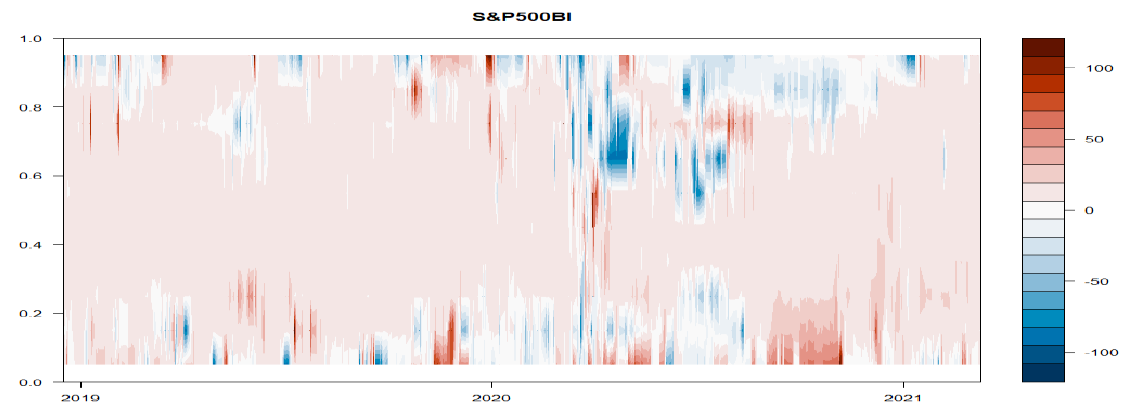
Figure 8. Results for net total directional connectedness for the S&P 500 Bond Index based on a 200-day rolling-window QVAR(1) and a 20-step-ahead forecast.